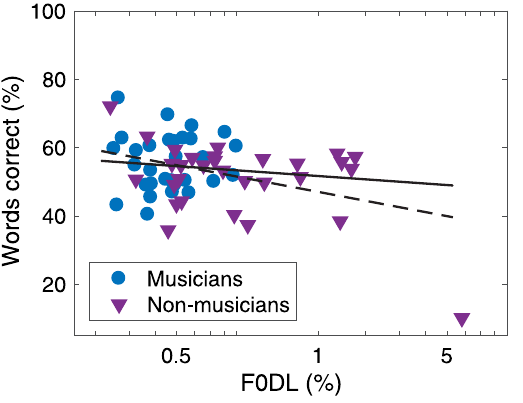
Figure 4. Proportion of correct words as a function of F0 difference limens. Speech scores were averaged across all conditions with overall or momentary F0 differences between target and maskers. Regression lines are shown for all participants (dashed line) and for 59 participants (solid